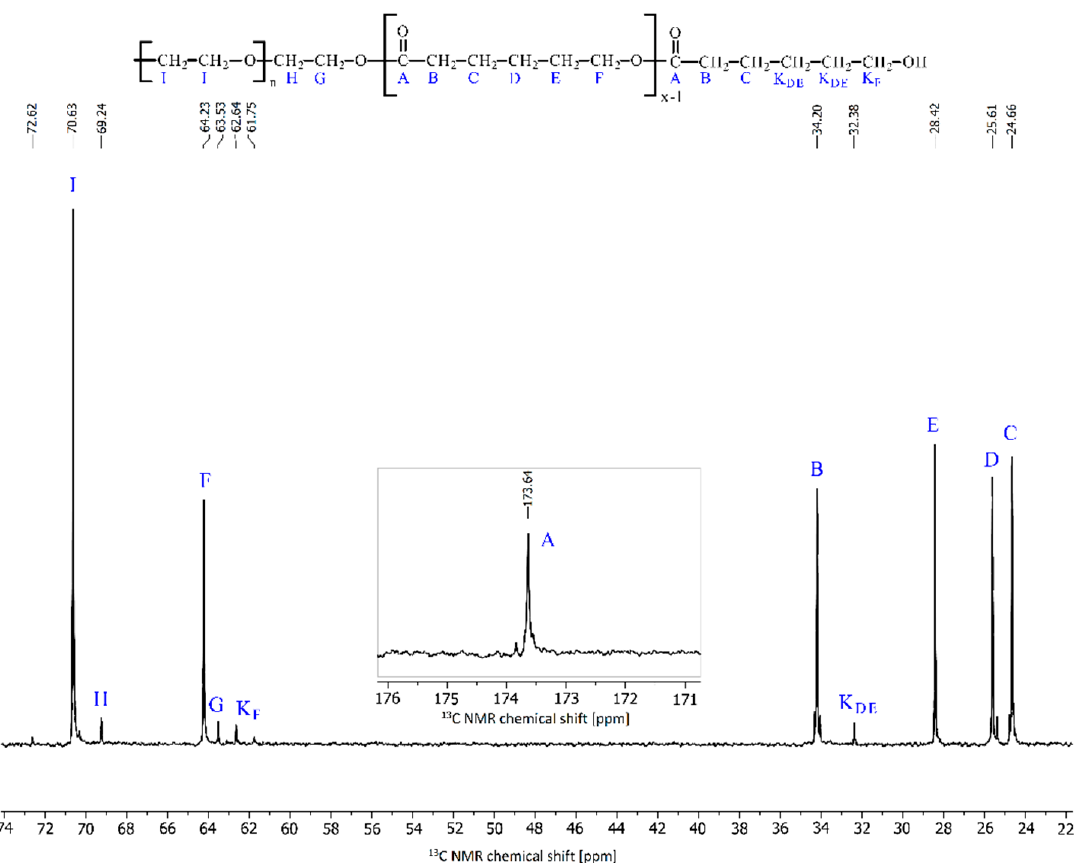
Figure 1. 1 H NMR spectrum of PCEC triblock copolymer.